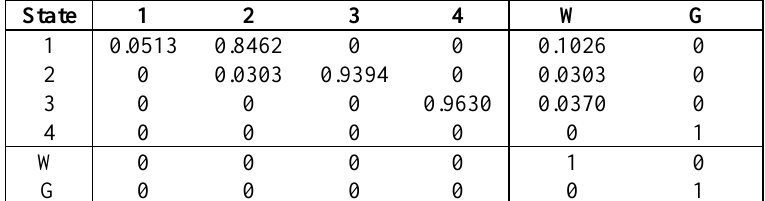
Table 5. The initial transition probability matrix